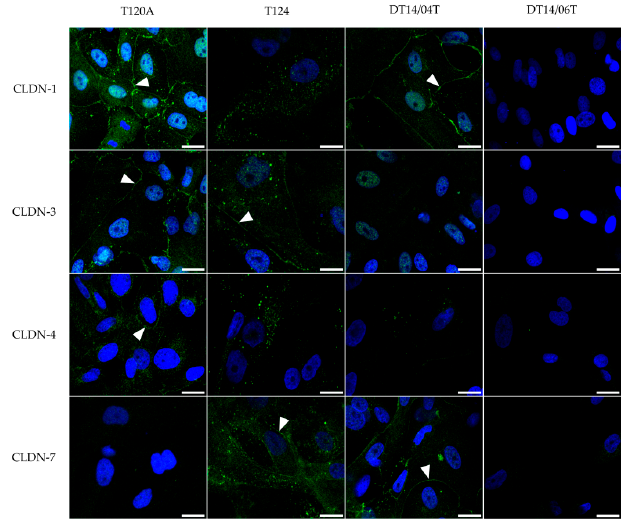
Figure 4. CLDN protein distribution and localization in cell lines T120A (p.37–42), T124 (p.12), DT14/04T (CLDN-1, -3 and -7: p.16-19; CLDN-4: p.5) and DT14/06T (p.44–49) as detected by IF. Cells were fixed and stained for CLDN-1, -3, -4 and -7 using fluorescein or FITC (fluorescein isothiocyanate) conjugated secondary antibodies, which are visible in green, and for nuclei using DAPI (4 ′ ,6-diamidino-2-phenylindol), which is visible in blue. Arrows indicate CLDN localization at cell–cell contacts. Scale bar: 20 µm.